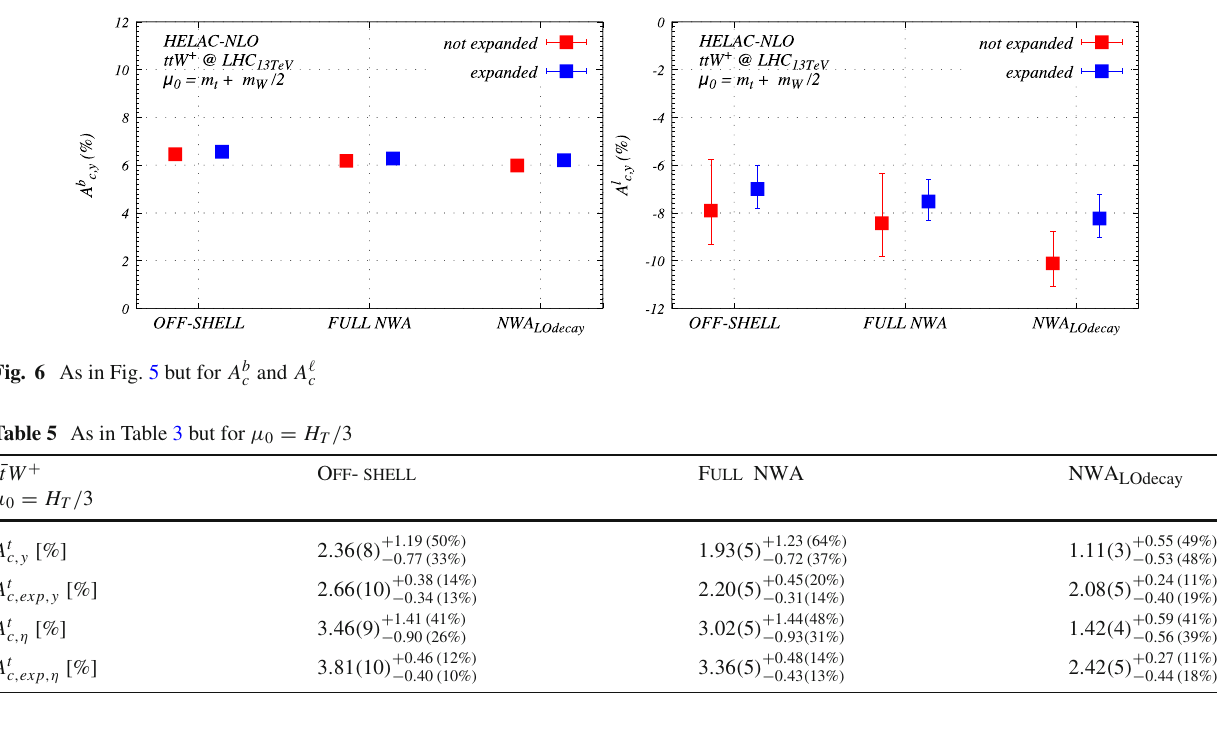
Table 6 As in Table 4 but for μ 0 = H T / 3